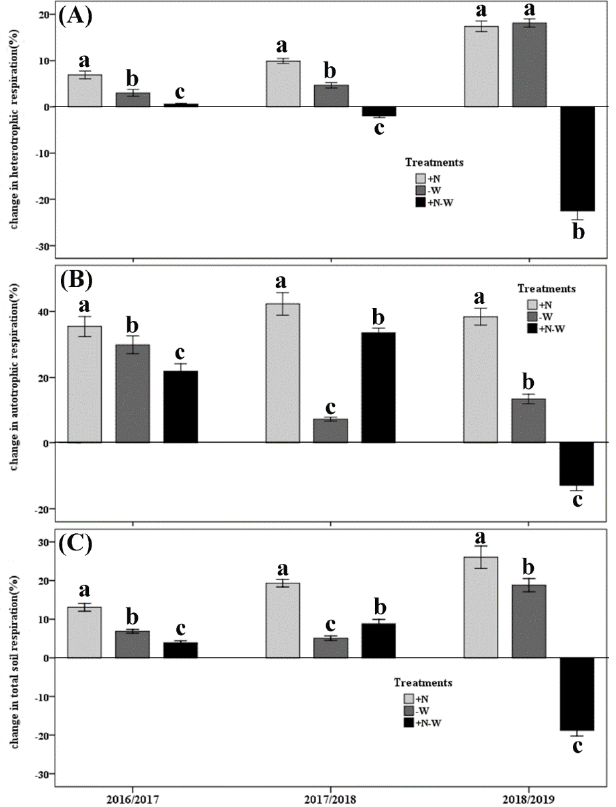
Figure 3. The changes of different treatments versus control treatment in the nongrowing season measurement periods. Significant differences among the different treatments are indicated by different letters. The error bars are standard errors. +N represents the N addition treatments; -W represents the precipitation reduction treatments; and +N-W represents the combined effect of N addition and precipitation reduction.